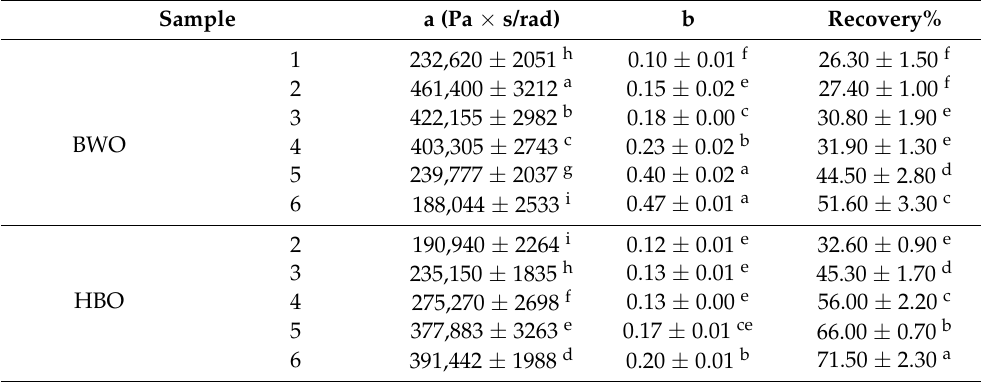
Table 4. Parameters of the power law (frequency sweep test) and structure recovery for margarines prepared with BWO and